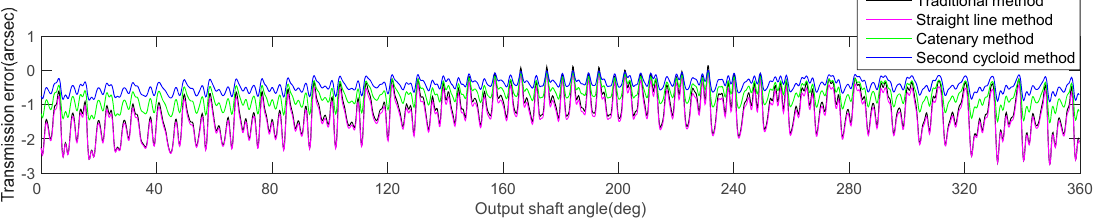
Figure 15. Static transmission error curves based on actual measurements.